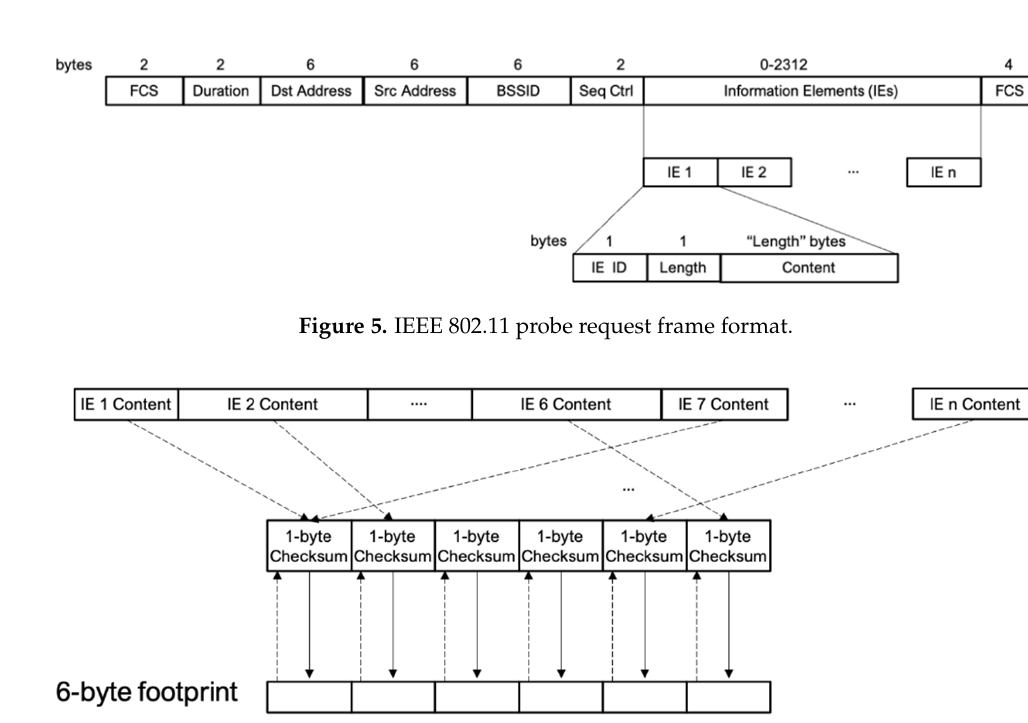
Table 1. Fields of the CSV files generated from captured probes.